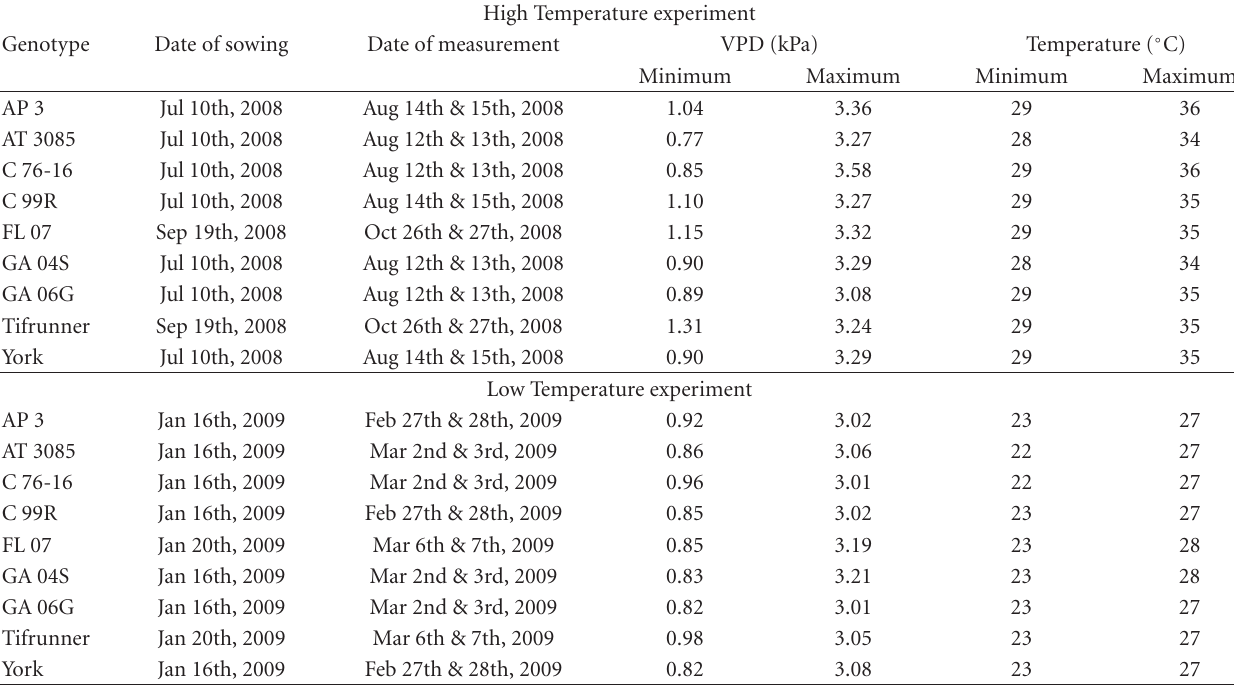
Table 1: Date of sowing, experimental dates, and environmental conditions during the measurements of response to vapor pressure deficit (VPD), minimum and maximum VPD, and